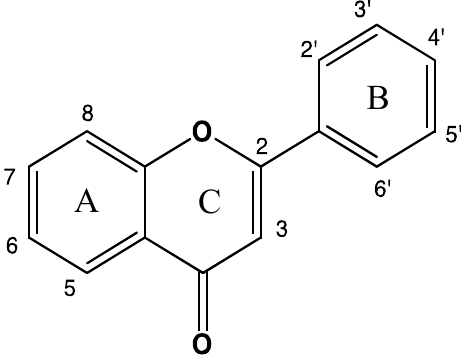
Figure 1. Structure of basic flavonoid skeletons.